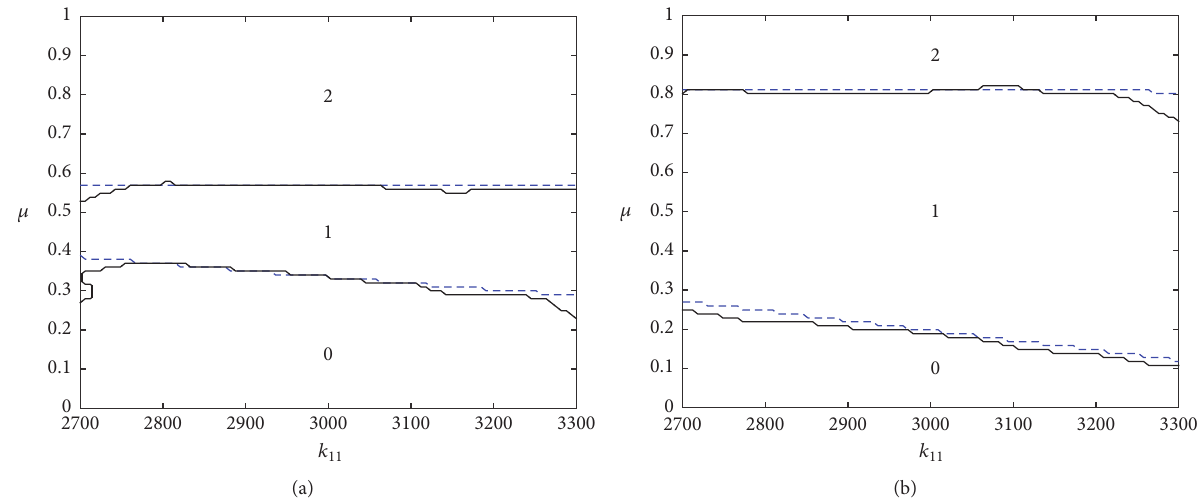
Figure 10: Number of unstable modes versus 𝜇 and 𝑘 11 for configurations 1 (a) and 2 (b): kriging on a 70 points’ LHS ( − ) and deterministic results